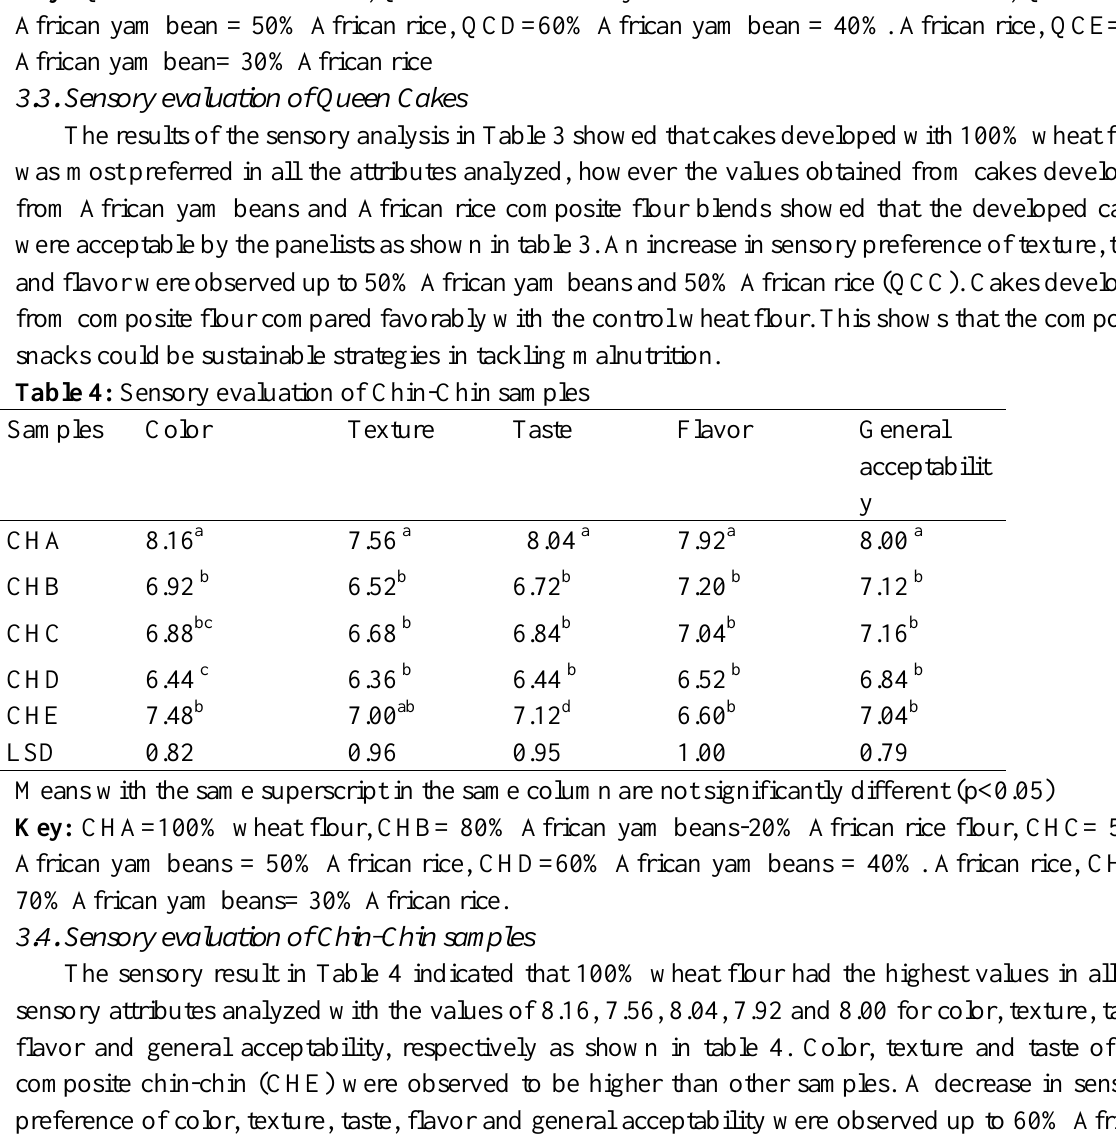
Means with the same superscript in the same column are not significantly different (p<0.05)